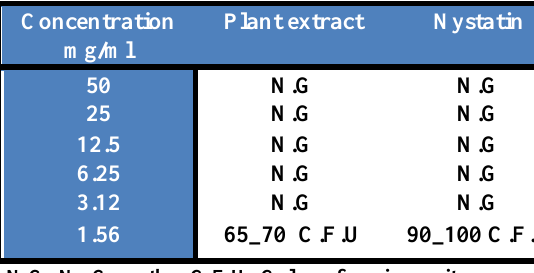
Table, 2: Minimum inhibitory concentration (MIC) of Datura stramonium on pathogenic Candida albicans .